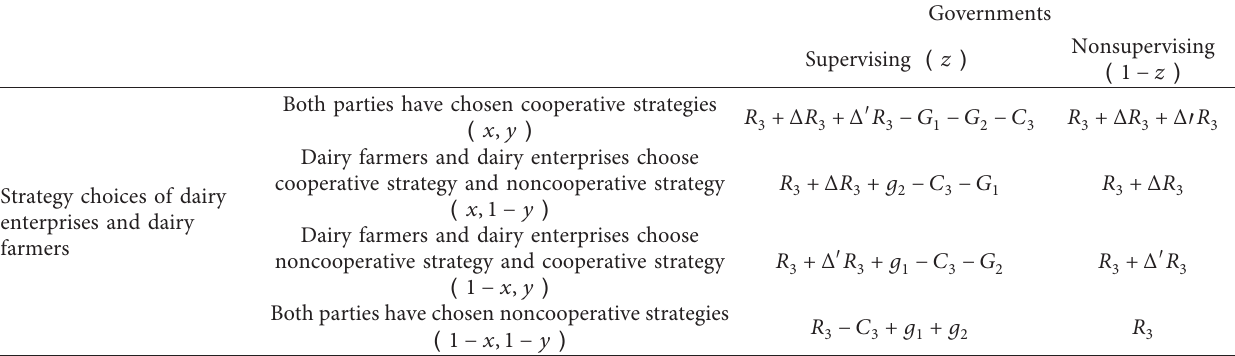
Table 3: The income matrix of the government in the forming process of the green dairy industry